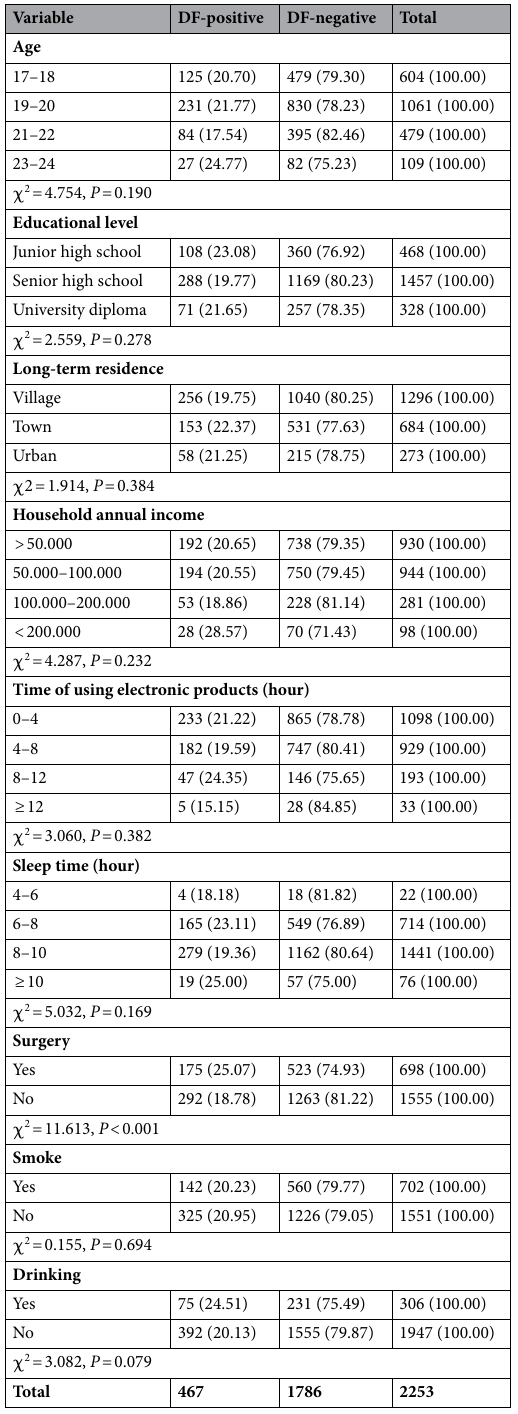
Table 3. Distribution of Demodex folliculorum (DF) in relation to studied variables [number